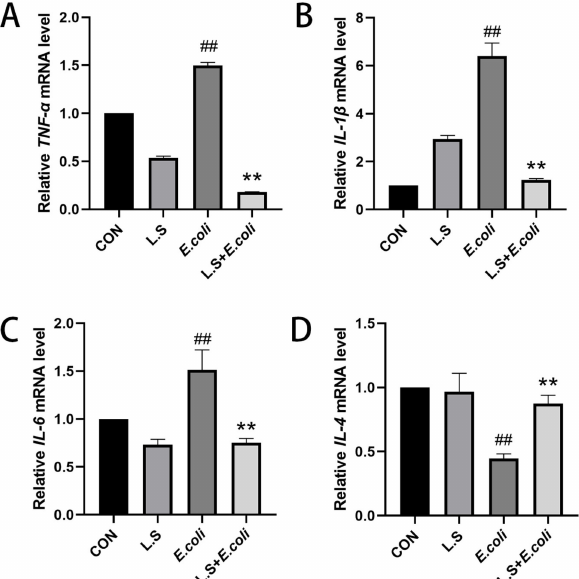
Figure 3. Relative expression of inflammatory factor mRNA in mouse jejunum tissue. Note: ## in the figure indicates a very significant difference compared with the CON group ( p < 0.01); ** indicates a very significant difference compared with the E. coli group ( p < 0.01). ( A ): Relative TNF- α mRNA expression, ( B ): Relative IL-1 β mRNA expression, ( C ) Relative IL-6 mRNA expression, ( D ) Relative IL-4 mRNA